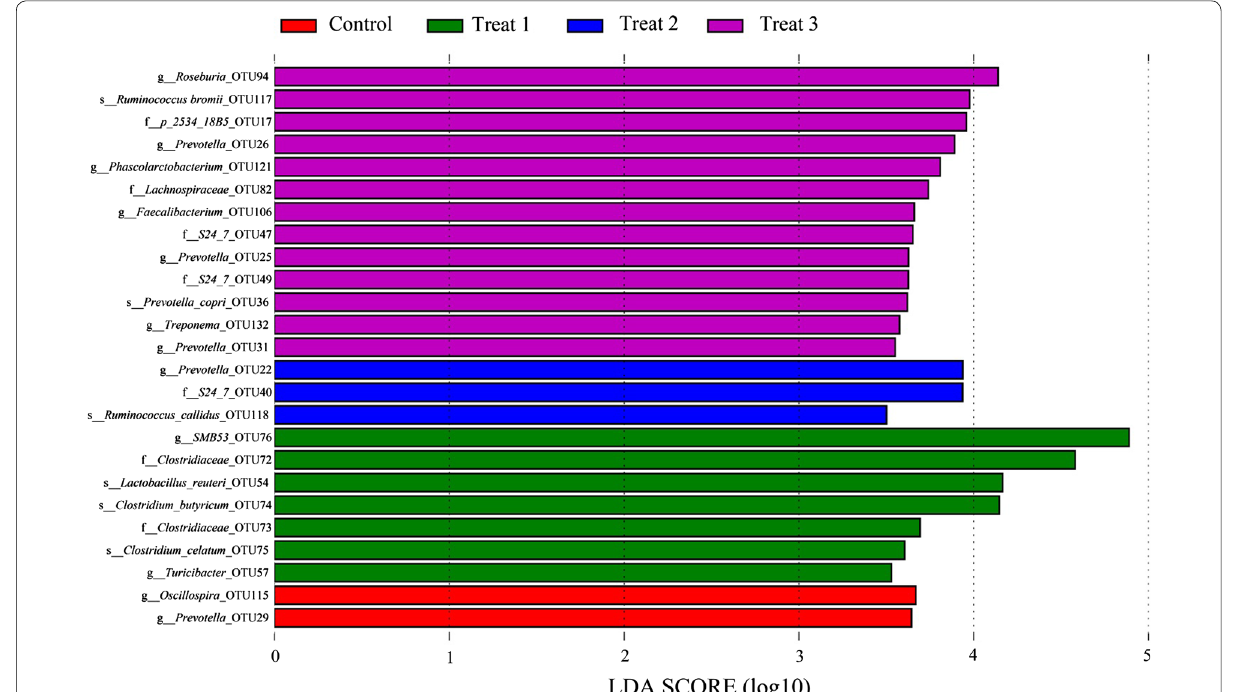
Only those genera that were significant different genera ( P < 0.05) among all groups are shown Data was expressed as mean SE obtained from 6 individual pigs each. Significant difference is indicated by different letters between groups. One-way analysis of ± variance (one-way ANOVA) with Tukey’s post hoc test was used to test the differences. P -values were corrected using false discovery rate (FDR). The group control, treat 1, treat 2, and treat 3 signify that feed is supplemented with 0, 5%, 10%, or 15% F fermented Mao-tai lees, respectively